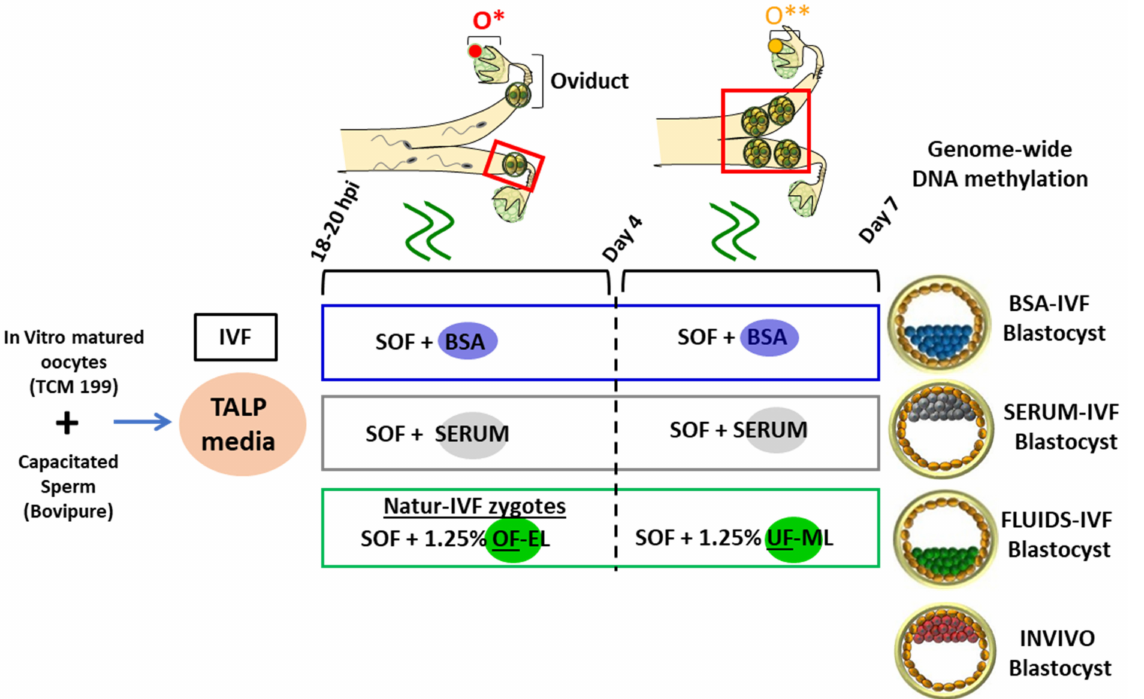
Figure 10. Schematic representation of the different steps of the IVF/EC system. Day 7 blastocysts in vitro were produced by oocyte in vitro maturation and fertilization, while presumptive zygotes were cultured from day 1 to 4 in SOF supplements either with 3 mg/mL BSA or 5% FCS or 1.25 OF, representing the time when the early embryo is in the oviduct and from day 4–7 in SOF supplements either with 3 mg/mL BSA or 5% FCS or 1.25 UF, representing the time when the embryo is in the uterine horn. Day 7 blastocysts in vivo were collected from superovulated donor heifers after flushing. O*: ovary with hemorrhagic corpus luteum; O**: early corpus luteum; OF-EL: oviductal fluid-early luteal; UF-ML: uterine fluid-mid